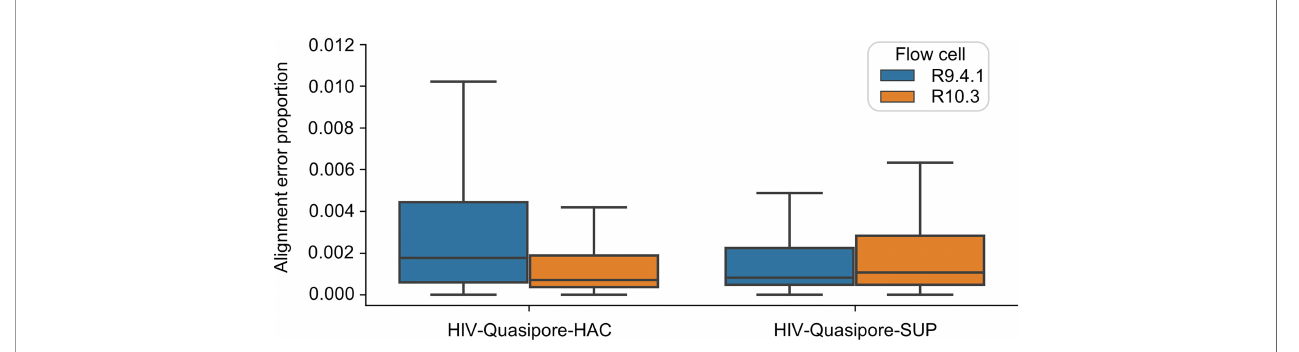
FIGURE 9 | Nanopore fl ow cell choice did not affect HIV-Quasipore error rates. Box plots display the distribution of read alignment errors when called by HIV- Quasipore-HAC and SUP for R9.4.1 and R10.3 data, represented by blue and orange